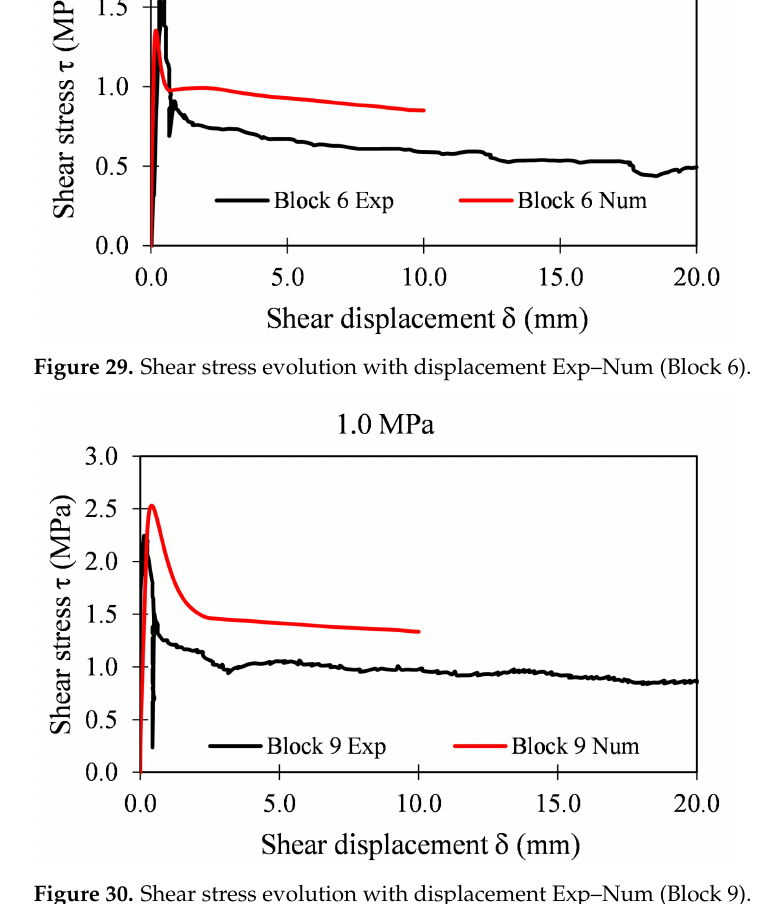
Figure 30. Shear stress evolution with displacement Exp–Num (Block